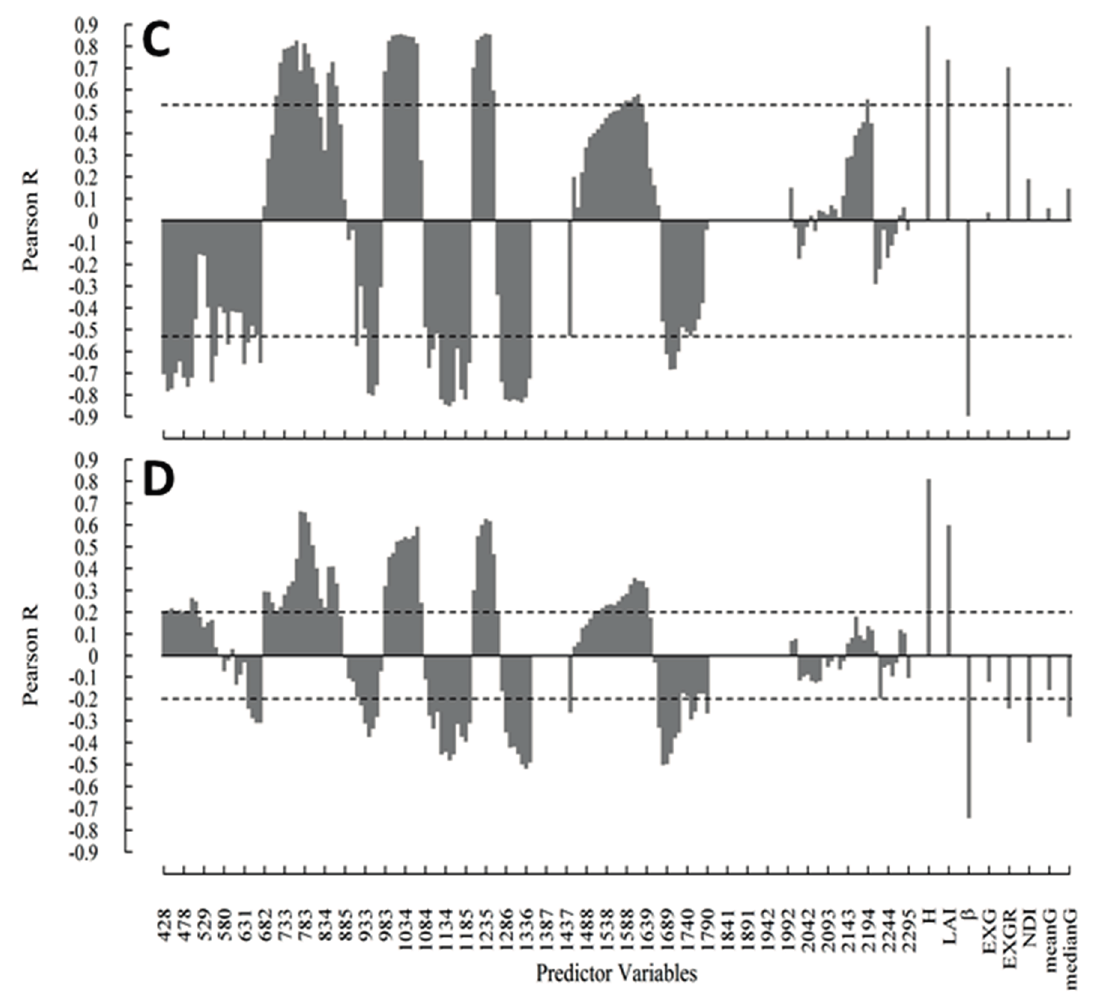
Figure 4. Pearson correlation between aboveground wet biomass and candidate non-spectral and 1st order derivative transformed spectral predictors for ( A ) rice, ( B ) alfalfa, ( C ) cotton, and ( D ) maize. The dashed line shows the threshold used to include predictors in the model-building phase. LAI is the leaf area index, β is the gap fraction, EXG is the excess greenness index, EXGR is the excess green minus excess red index, NDI is the normalized difference index, meanG is the mean chromatic greenness index, and medianG is the median chromatic greenness index. The hyperspectral narrowbands are in